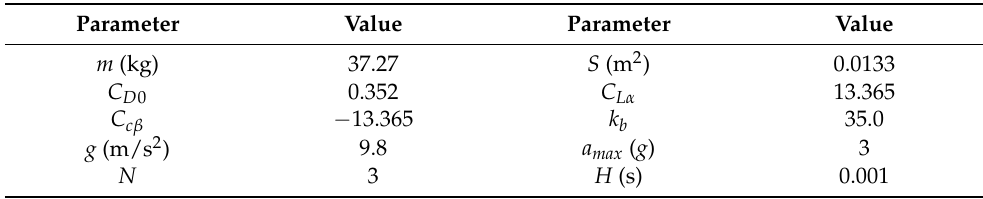
Table 1. Simulation parameters.